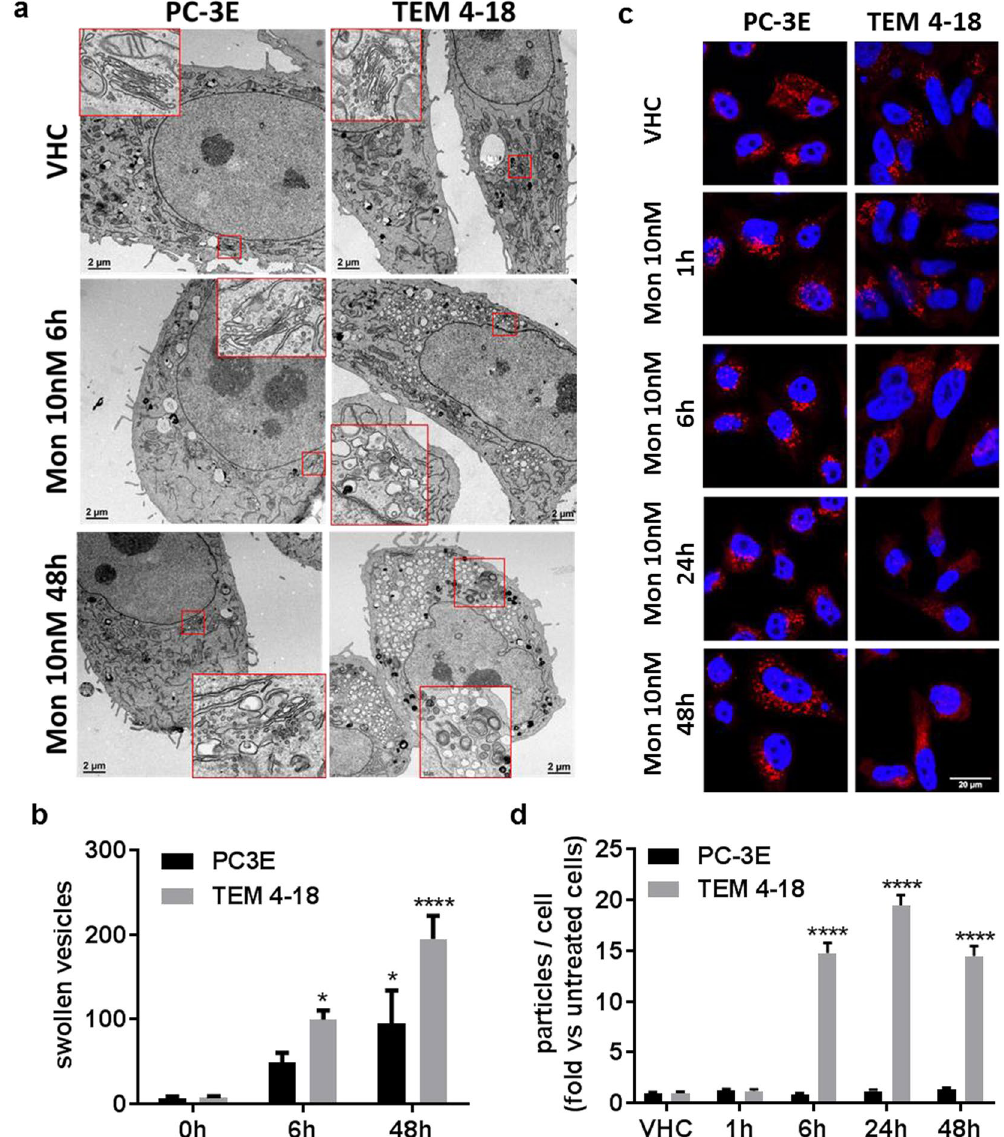
Figure 4. Golgi apparatus disruption is an early effect of monensin in TEM 4-18 cells. ( a ) Transmission electron microscopy was performed on cells treated with monensin (10 nM) for 6 h or 48 h. Scale bar: 2 µ m. ( b ) Quantification of the number of swollen vesicles present in the cytoplasm (n ≥ 5). ( c ) Cells treated with monensin (10 nM) for 1 h to 48 h. Cells were stained for GM130 (red) and nucleus (blue). Scale bar: 20 µ m. ( d ) GM130 signal was converted into binary signal and number of particles were counted using ImageJ and normalized to the number of particles in untreated cells (n ≥ 25). Data represent mean values ± SEM. * p < 0.05, ** p < 0.01, *** p < 0.005, **** p <